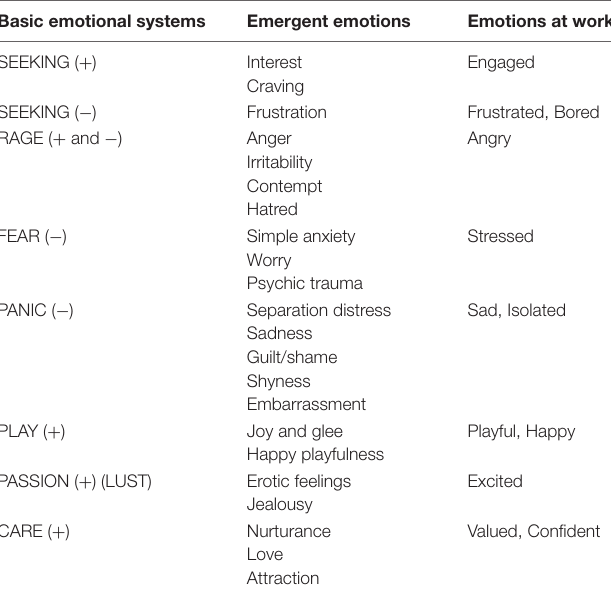
TABLE 1 | Postulated relationships (first and second column) between basic emotional systems and common emotional processes (Panksepp, 2006). Basic emotional